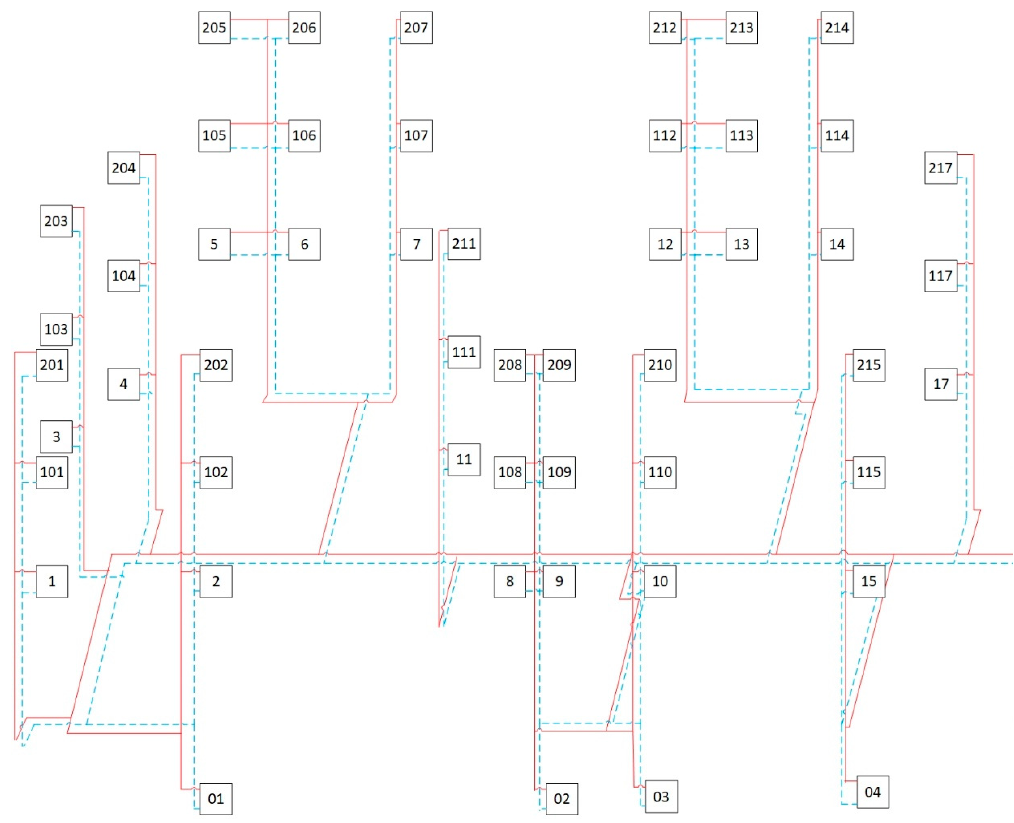
Figure 2. 3D representation of part of the radiator system of the building case study in Viborg, Denmark. The vertical pipe sections are the different risers in connection with the horizontal lines that represent the main distribution pipes in the basement. Red depicts supply while blue depicts the return pipe sections. The unique number inside each box identifies the specific radiator among the rest of the radiators in the system.